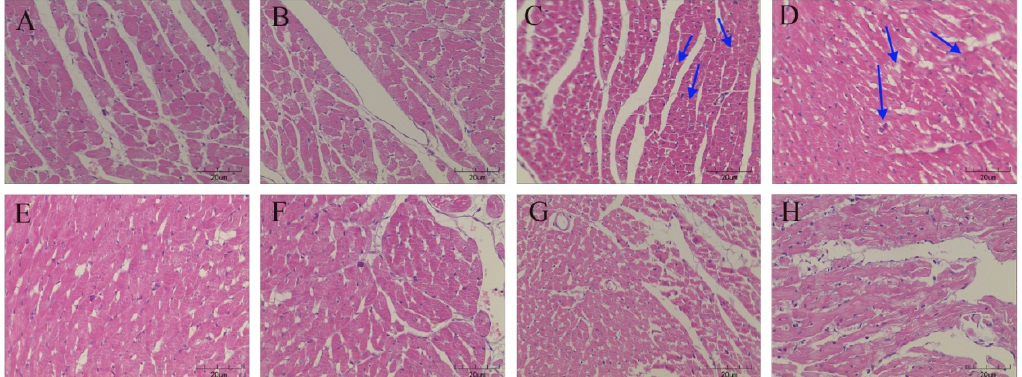
Figure 3. The results of pathological changes in the rat heart tissue after different treatments. (H&E staining × 400). ( A , B ) Control; ( C , D ) CuSO 4 ; ( E , F ) GDL + CuSO 4 ; ( G , H ) Penicillamine + CuSO 4 . The arrows indicated the pathological changes in the rat heart tissue after CuSO 4 exposure.